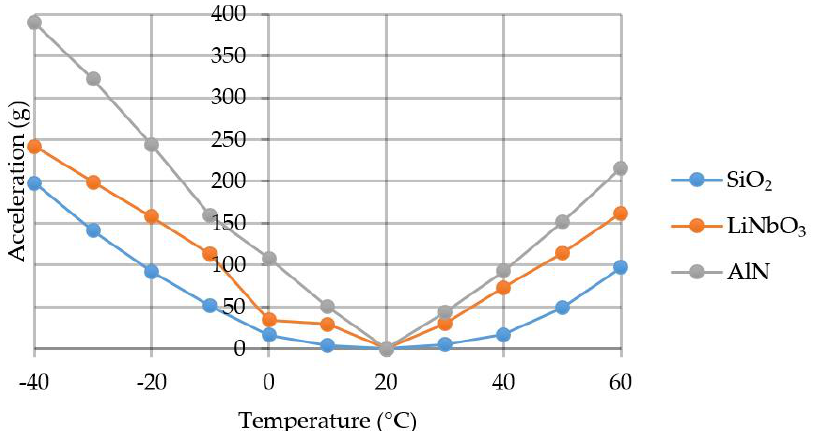
Figure 15. Graph of the minimum acceleration value.